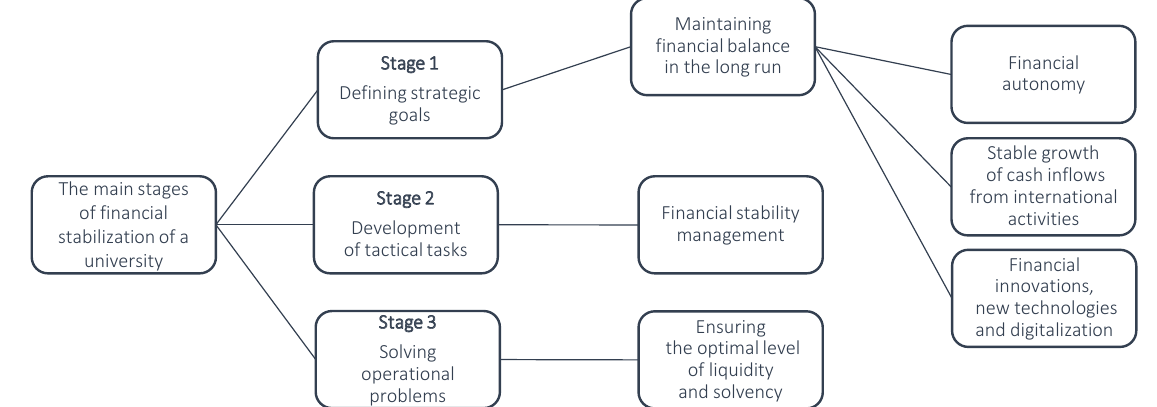
Figure 1. Stages of the university’s financial